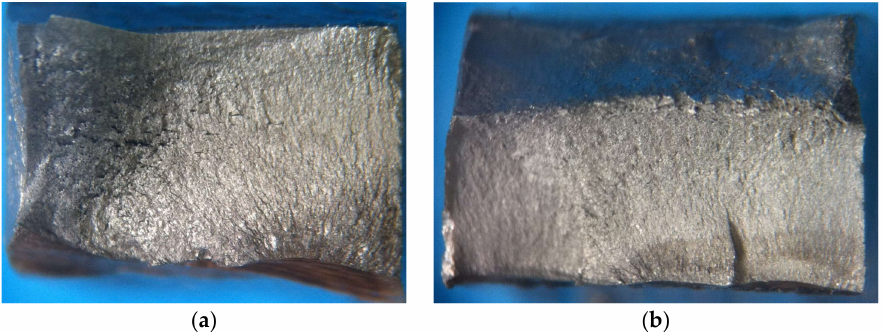
Figure 18. Stereo microscopy of fatigue surfaces. Sample 1S-G, with 898,000 cycles to failure ( a ) and sample 3S-E, with 75,000 cycles to failure ( b